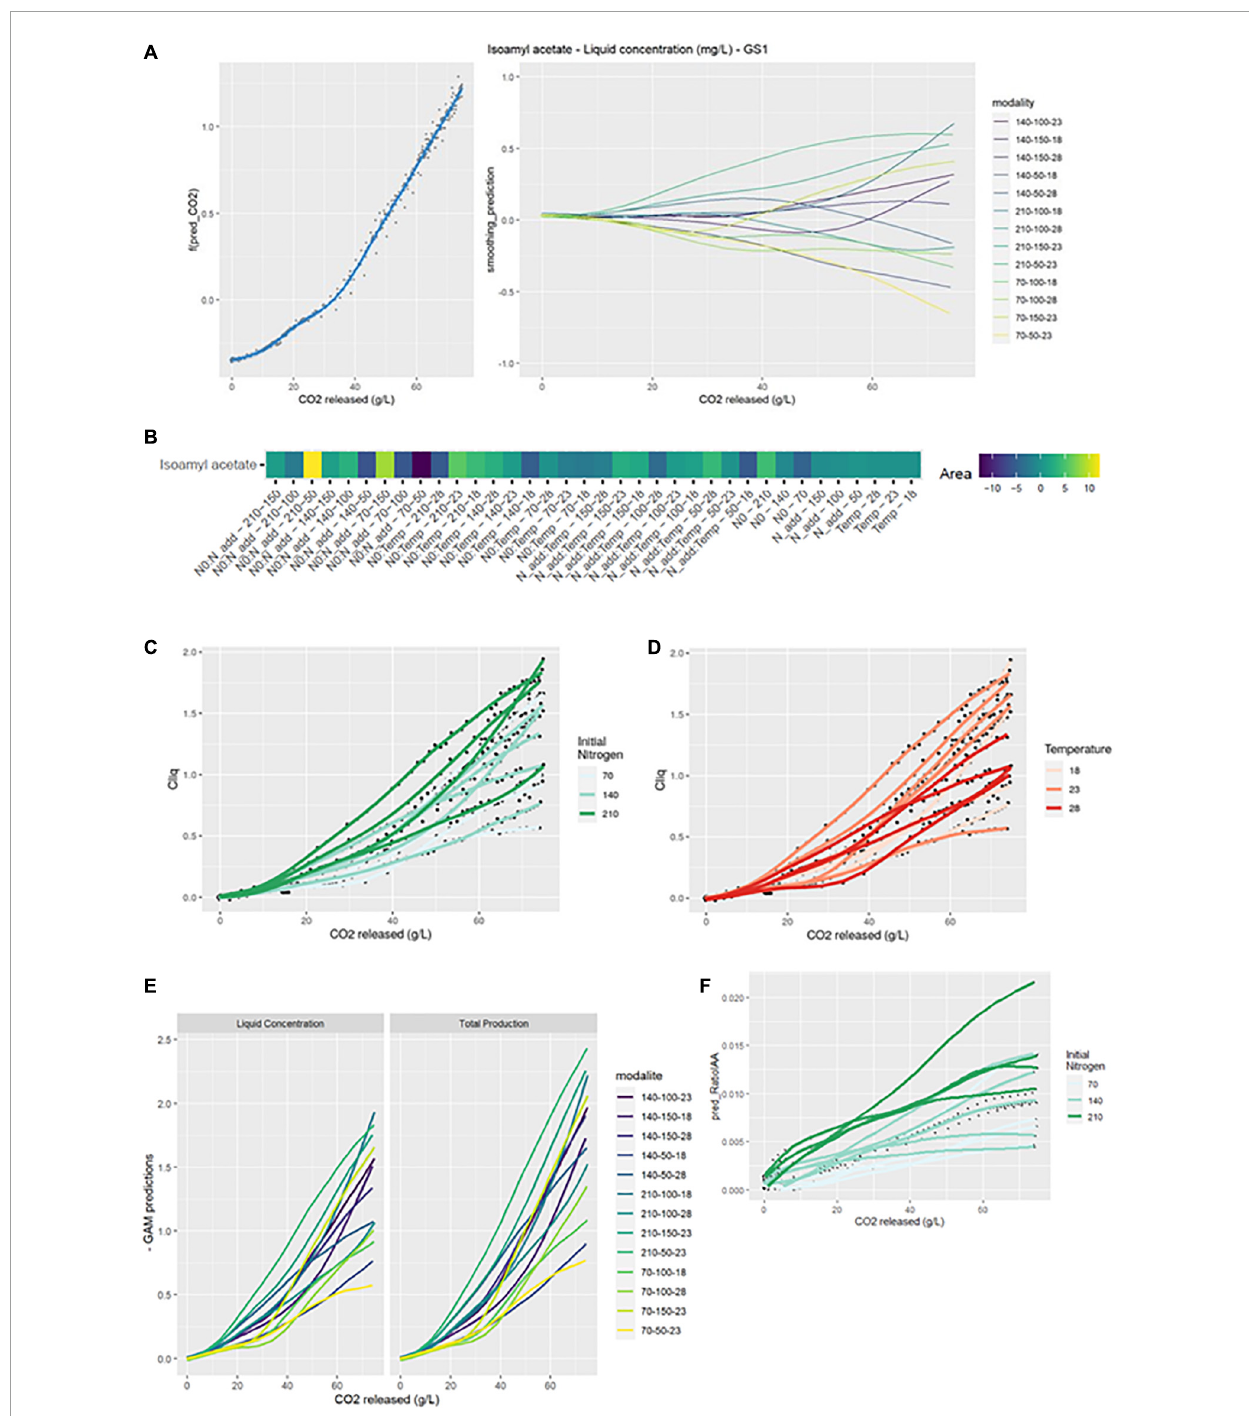
FIGURE3 GAM modeling of IAA production kinetics. (A) Left: Smoothing average of IAA concentration, right: Deviations of each modality from this average smoothing. (B) Heatmap representing magnitudes of each factor and every possible interaction using areas under the curves of the deviations from the average smoothing. (C,D) Prediction curves for each modality represented with a color depending on the level of NO and temperature. (E) Comparison between liquid concentration and total production. (F) Predicted ratio of lAA to lSOH vs. CO 2 released, with a color depending on the level of